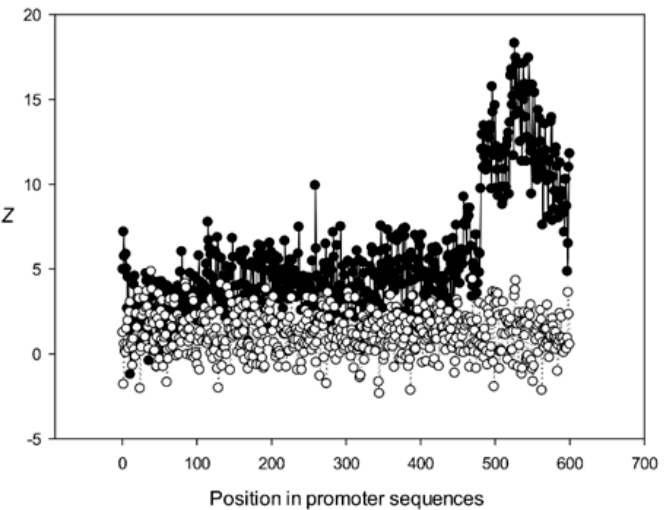
Figure 9. Dependence of Z on position l for promoter sequences of the first class. Black circles indicate multiple alignment of promoter sequences of the first class and white circles indicate randomly mixed promoter sequences where positions of indels were maintained.